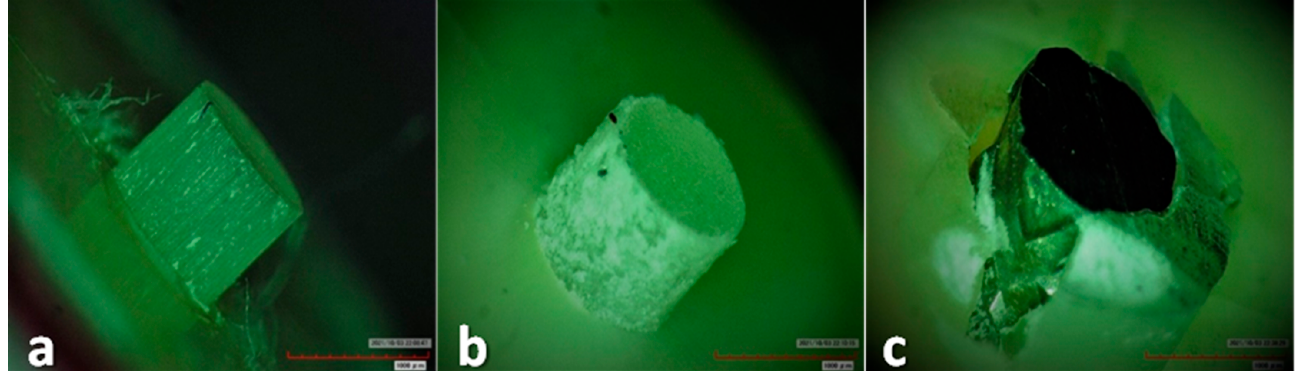
Figure 6. ( a ): Digital microscopic picture showing adhesive failure of cement–post interface; ( b ): Spec- imen showing adhesive failure of cement–dentin interfaces; ( c ): Specimen showing mixed